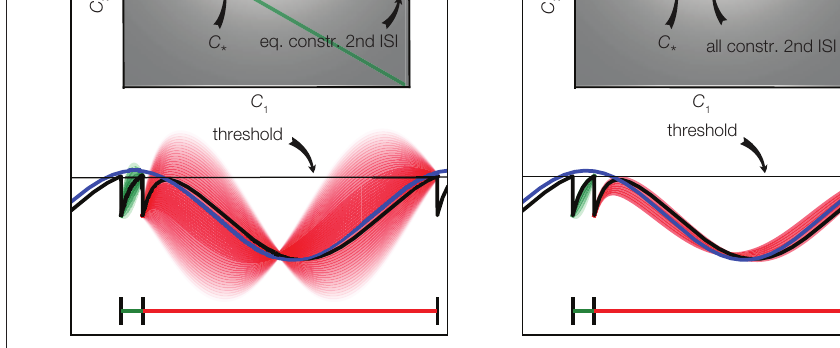
plot. The same is shown for the second interspike interval in red. The perfect reconstruction of the stimulus (coefficients) is found by the intersection of the linear constraints. The brightness of the background indicates the probability of each pair of coefficients according to the prior distribution. (B) Equality and inequality constraints: The same configuration as in (A) is plotted, but additionally the inequality constraints imposed by the period of silence between spike times are taken into account as well. This results in a smaller subspace of possible solutions as shown in the upper plot.